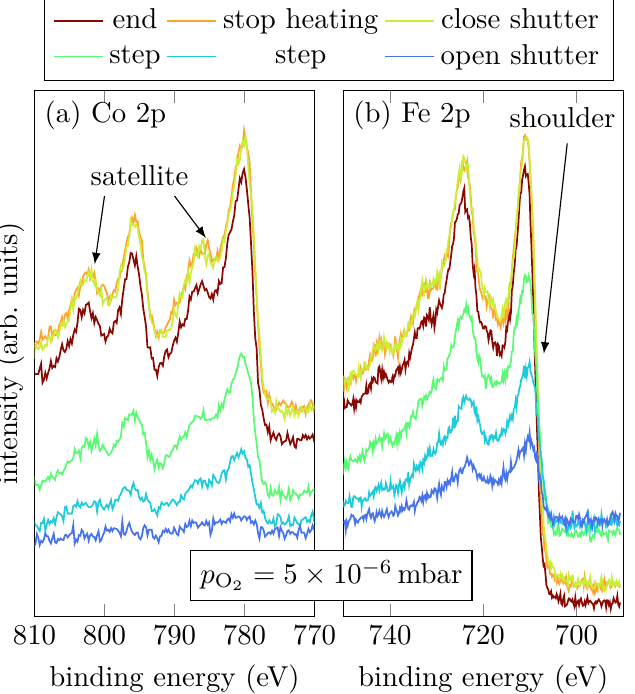
Figure 6. HAXPES spectra of sample C for characteristic events, as displayed, of the Fe 2p and Co 2p